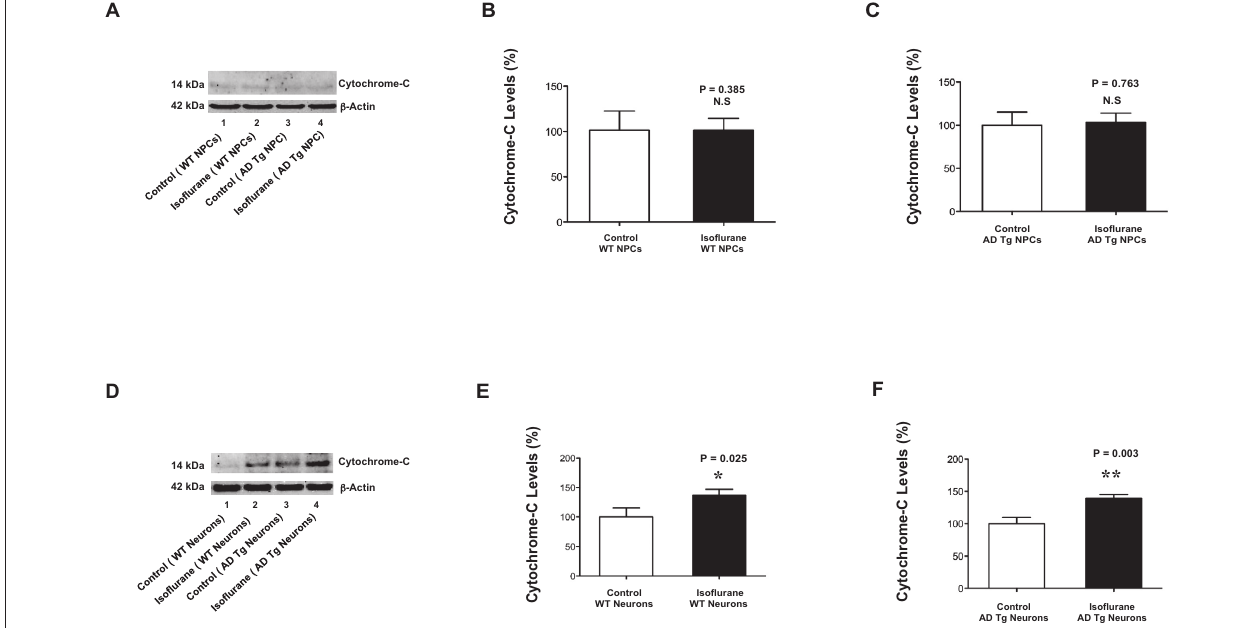
FIGURE 3 | Isoflurane increases cytochrome c levels in mice neurons but not in mice NPCs.(A) There is no visible difference in the cytosol cytochrome c levels between the control condition (lane 1) and the isoflurane treatment (lane 2) in the WT mice NPCs. There is no visible difference in the cytochrome c levels between the control condition (lane 3) and the isoflurane treatment (lane 4) in the AD Tg mice NPCs. (B) The quantification of the Western blot shows that the isoflurane treatment (black bar) does not increase cytosol cytochrome c level as compared to control condition (white bar) in the WT mice NPCs. (C) The quantification of the Western blot shows that the isoflurane treatment (black bar) does not increase cytosol cytochrome c levels as compared to the control condition (white bar) in AD Tg mice NPCs. (D) There is a visible increase in